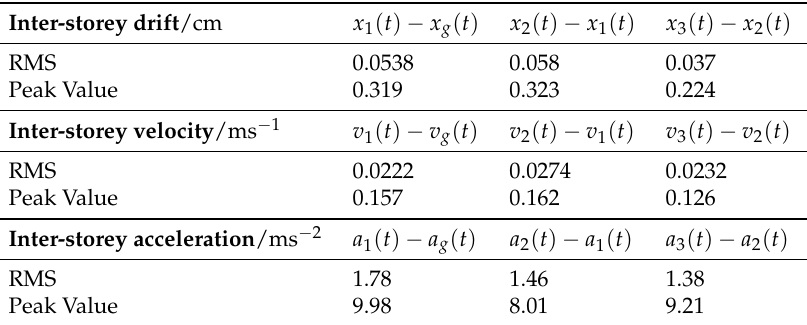
Table 3. Closed-loop RMS and peak values assuming an ad-hoc tuned brain–emotional learning-based intelligent control (BELBIC)